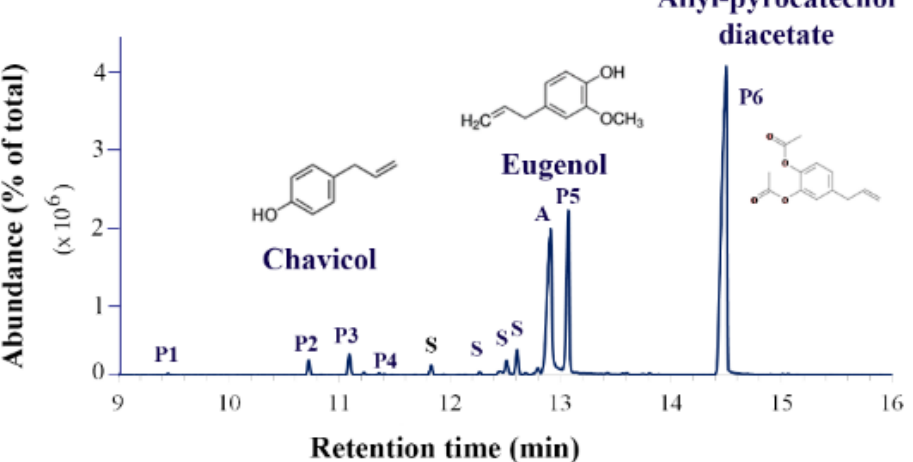
Figure 2. Phenylpropanoid constituents detected in the BE using GC-MS. Peak P1, chavicol; peak P2, chavicol acetate; peak P3, isoeugenol; peak P4, methyl eugenol; peak P5, eugenol acetate; peak P6, allyl-pyrocatechol diacetate. S, sesquiterpenes; A, alkaloid.